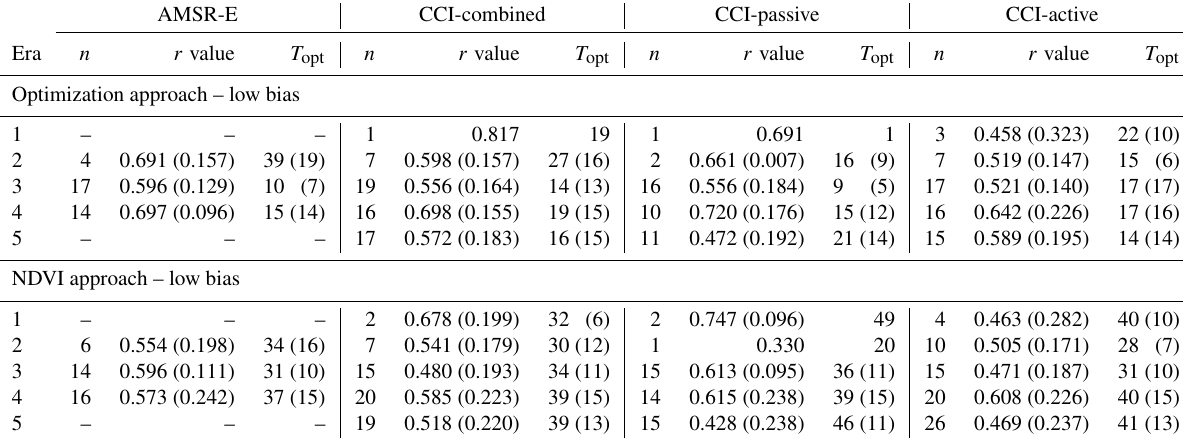
Table 4. Average lagged r values and T opt between SWI based on optimization and in situ soil moisture at the 20.32cm depth for the SCAN network (Figs. 1 and 2). Standard derivation is indicated in parentheses. The n value represents the number of observations.